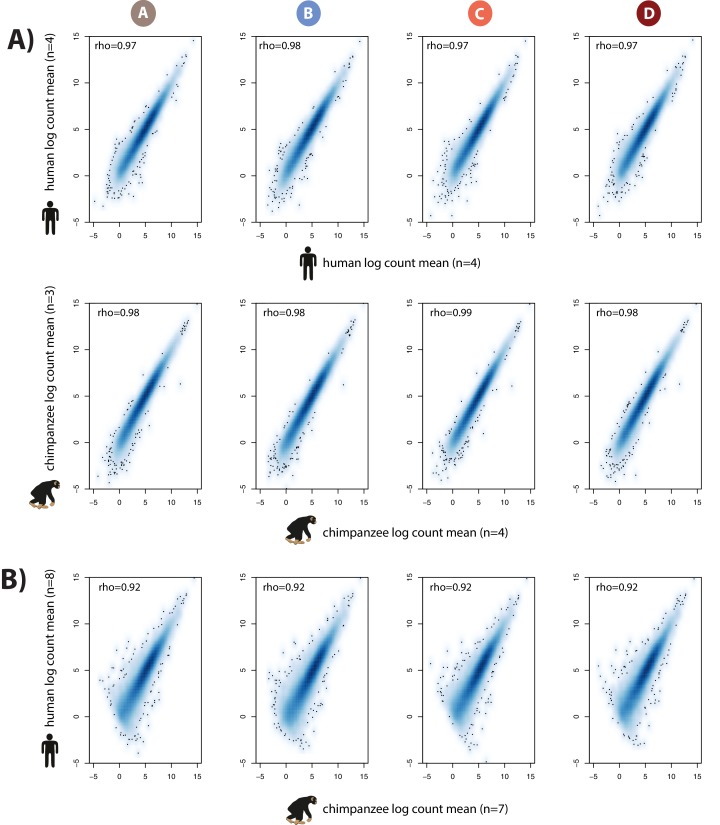
Inter-species variability in read counts is greater than intra-species variability.(A) Spearman correlation of per-gene RNA-seq read counts between individuals of the same species within a condition. Mean read counts per gene in four human individuals versus mean read counts per gene in four independent human individuals are shown in the top panel. Mean read counts in four chimpanzee individuals versus mean read counts in three independent chimpanzee individuals are shown in the lower panel. Each column represents one of the four conditions – A, B, C and D. (B) Mean chimpanzee (seven individuals) read counts versus mean human (eight individuals) read counts.